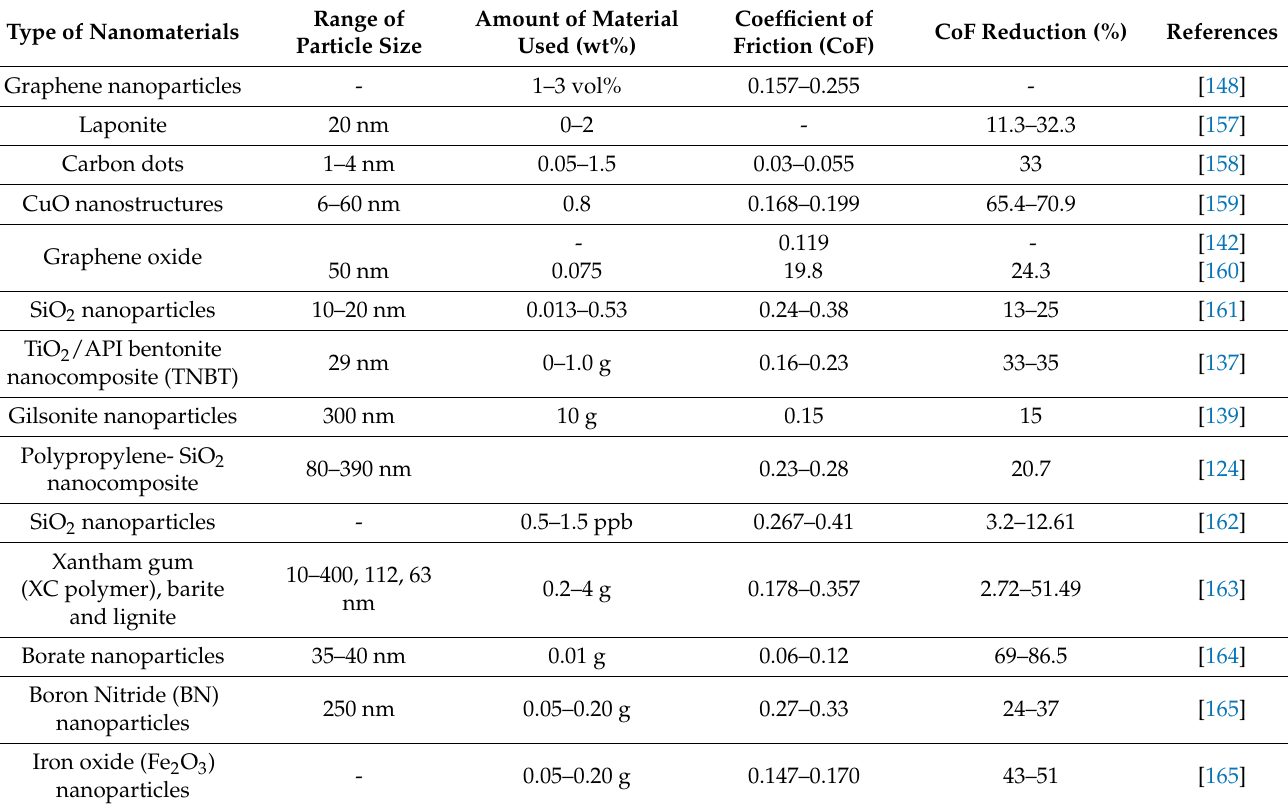
Table 3 represents the variety of nanomaterials used as lubricant in water-based drilling fluids. Table 3. Role of various nanomaterials used as lubricants in drilling